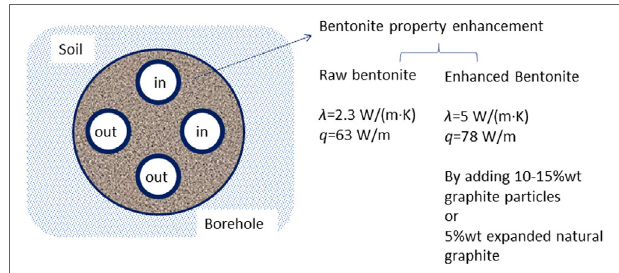
FigURe 6 | Heat conduction enhancement of grouting materials used in borehole double-U heat exchangers by graphite additives (particles and natural worm) could reduce pipe length and increase heat transfer rate. Data adapted from Delaleux et al.